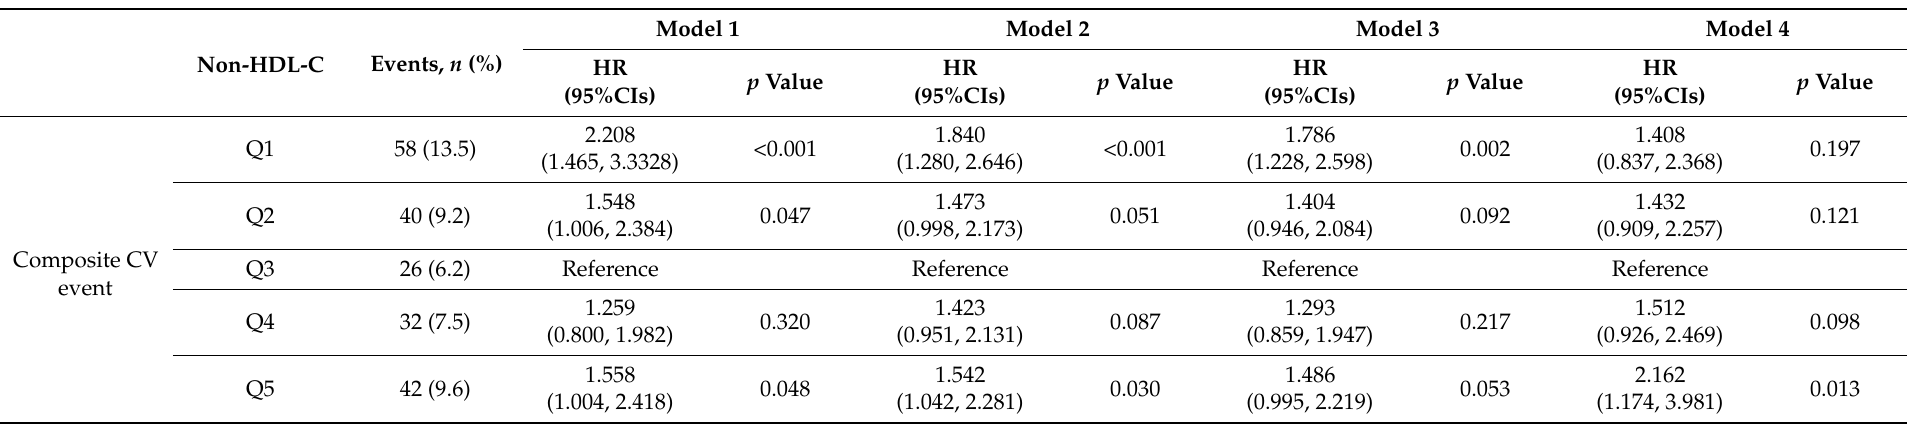
Table 2. HRs for the primary outcome by non-HDL-C level.